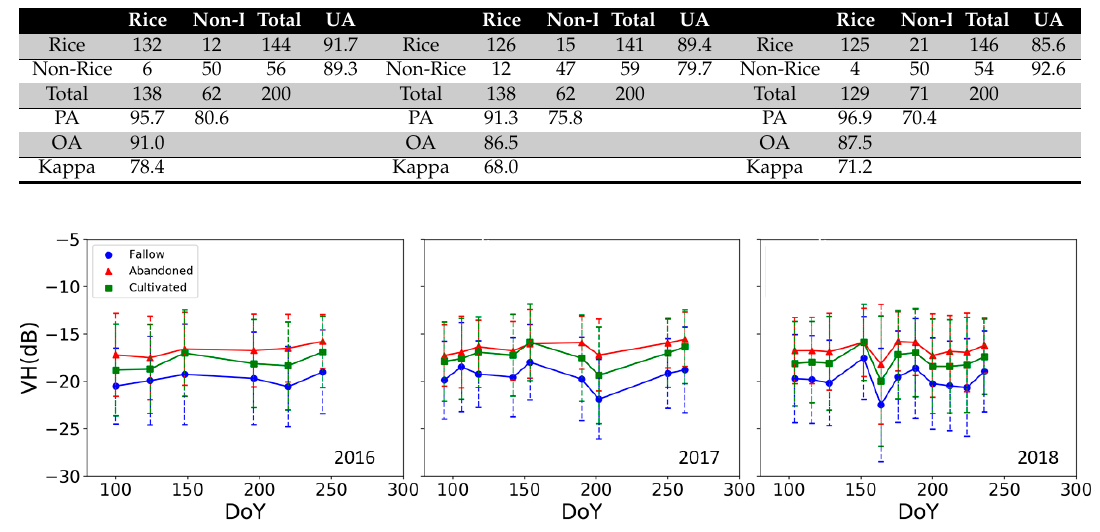
Figure 7. Time series box and whisker plots during key growth stages for 2016 to 2018 for rice outcomes (fallow, abandoned, and cultivated) using VH polarization Sentinel-1 C-band radar. DoY: Day of Year. Table 1. Accuracy assessment for 2016, 2017, and 2018 using co-timed VHR optical imagery. OA: Overall accuracy; PA: Producer’s accuracy; UA: User’s accuracy.